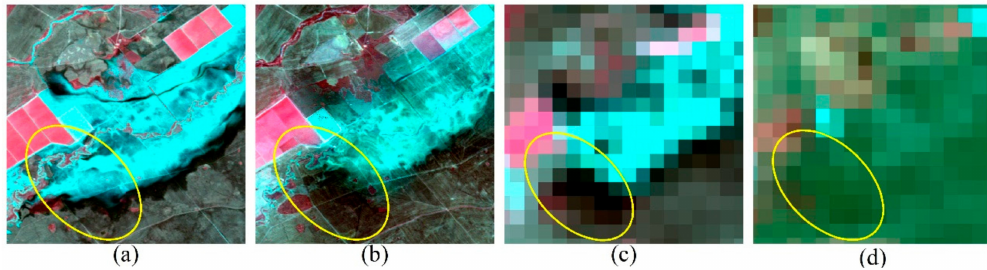
Figure 10. Di ff erences comparison between the predicted image by EFSDAF and input images in dataset 2. From left to right: ( a ) Landsat image at T P ; ( b ) Landsat-like image by EFSDAF at T P ; ( c ) MODIS image at T P ; ( d ) MODIS image at T B